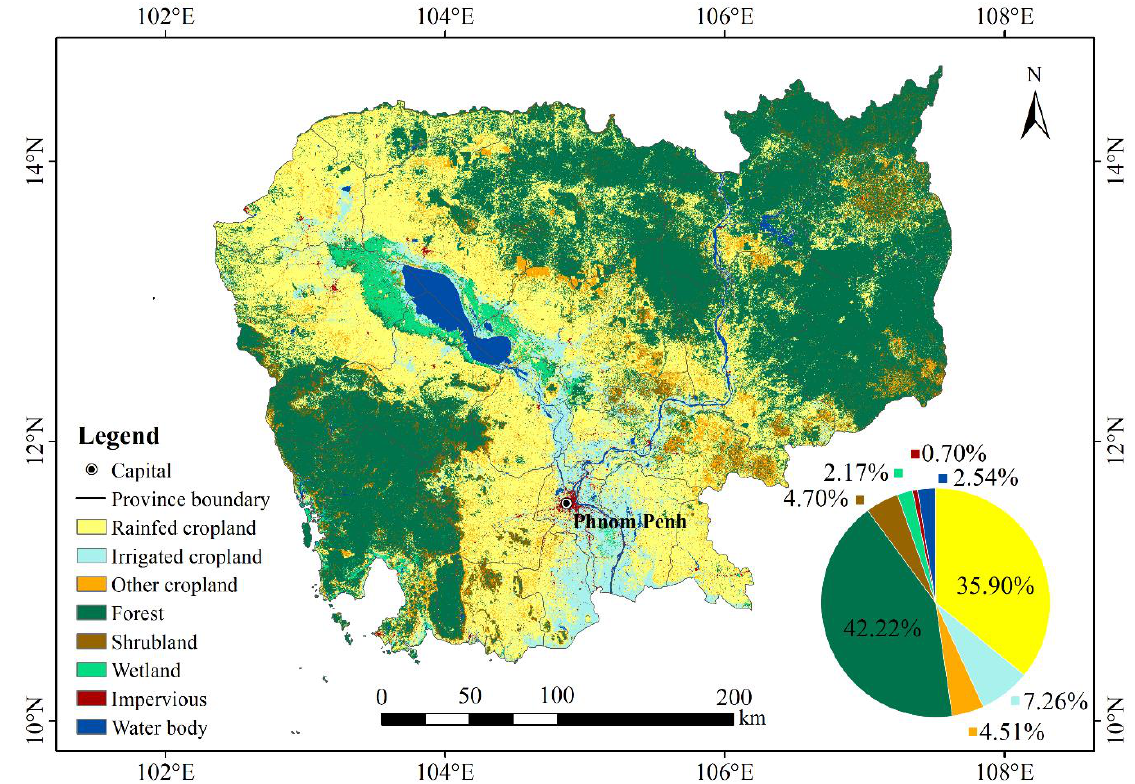
Figure 2. Land use/cover map in 2020.